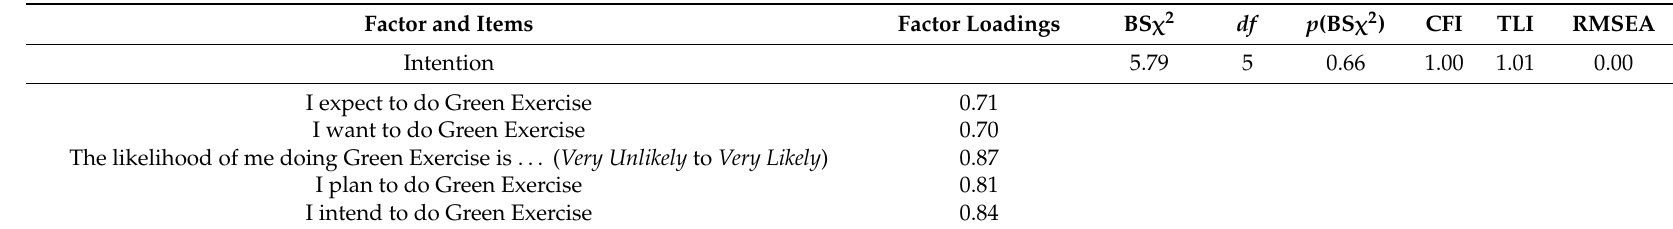
Table 8. Fit statistics and factor loadings of the intentions to perform green exercise